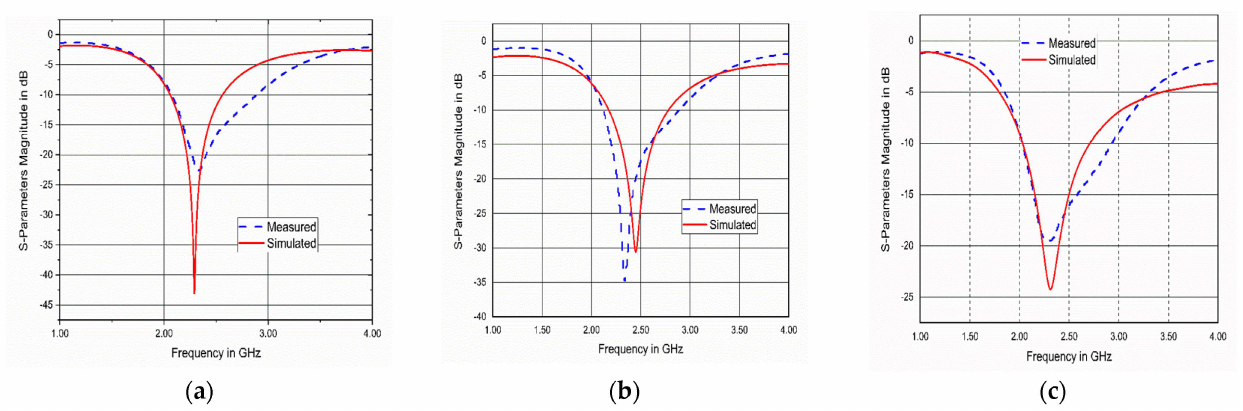
Figure 16. The measurement setup. ( a ) Muscle phantom; ( b ) Liver phantom; ( c ) Kidney phantom.